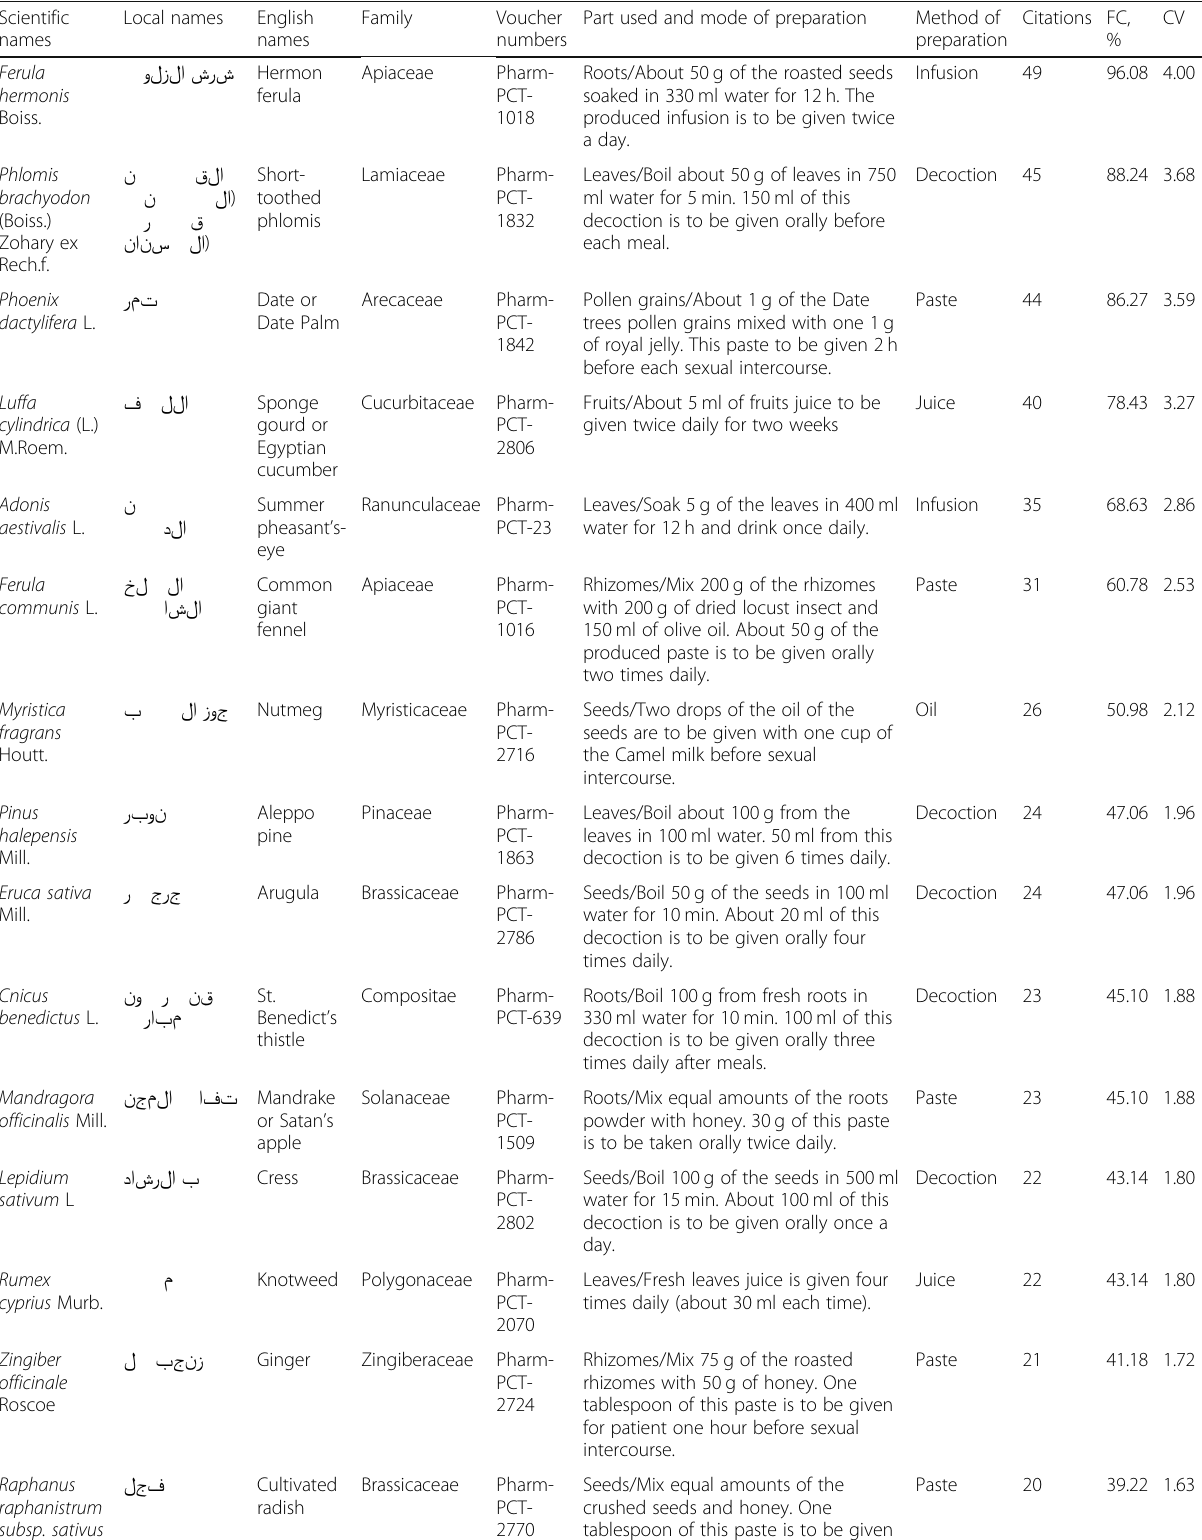
Table 3 The used herbals for the treatment of infertility in males, the plant ’ s parts used, Frequency of Citations (FC), Choice values, modes of administration and methods of